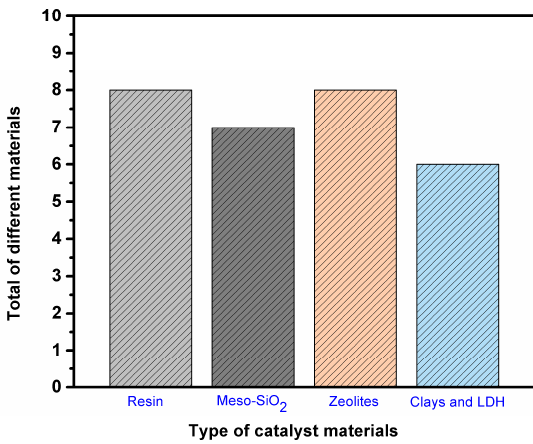
Figure 1. Popularity of different types of catalytic materials for solketal production from 2014 to 2018.